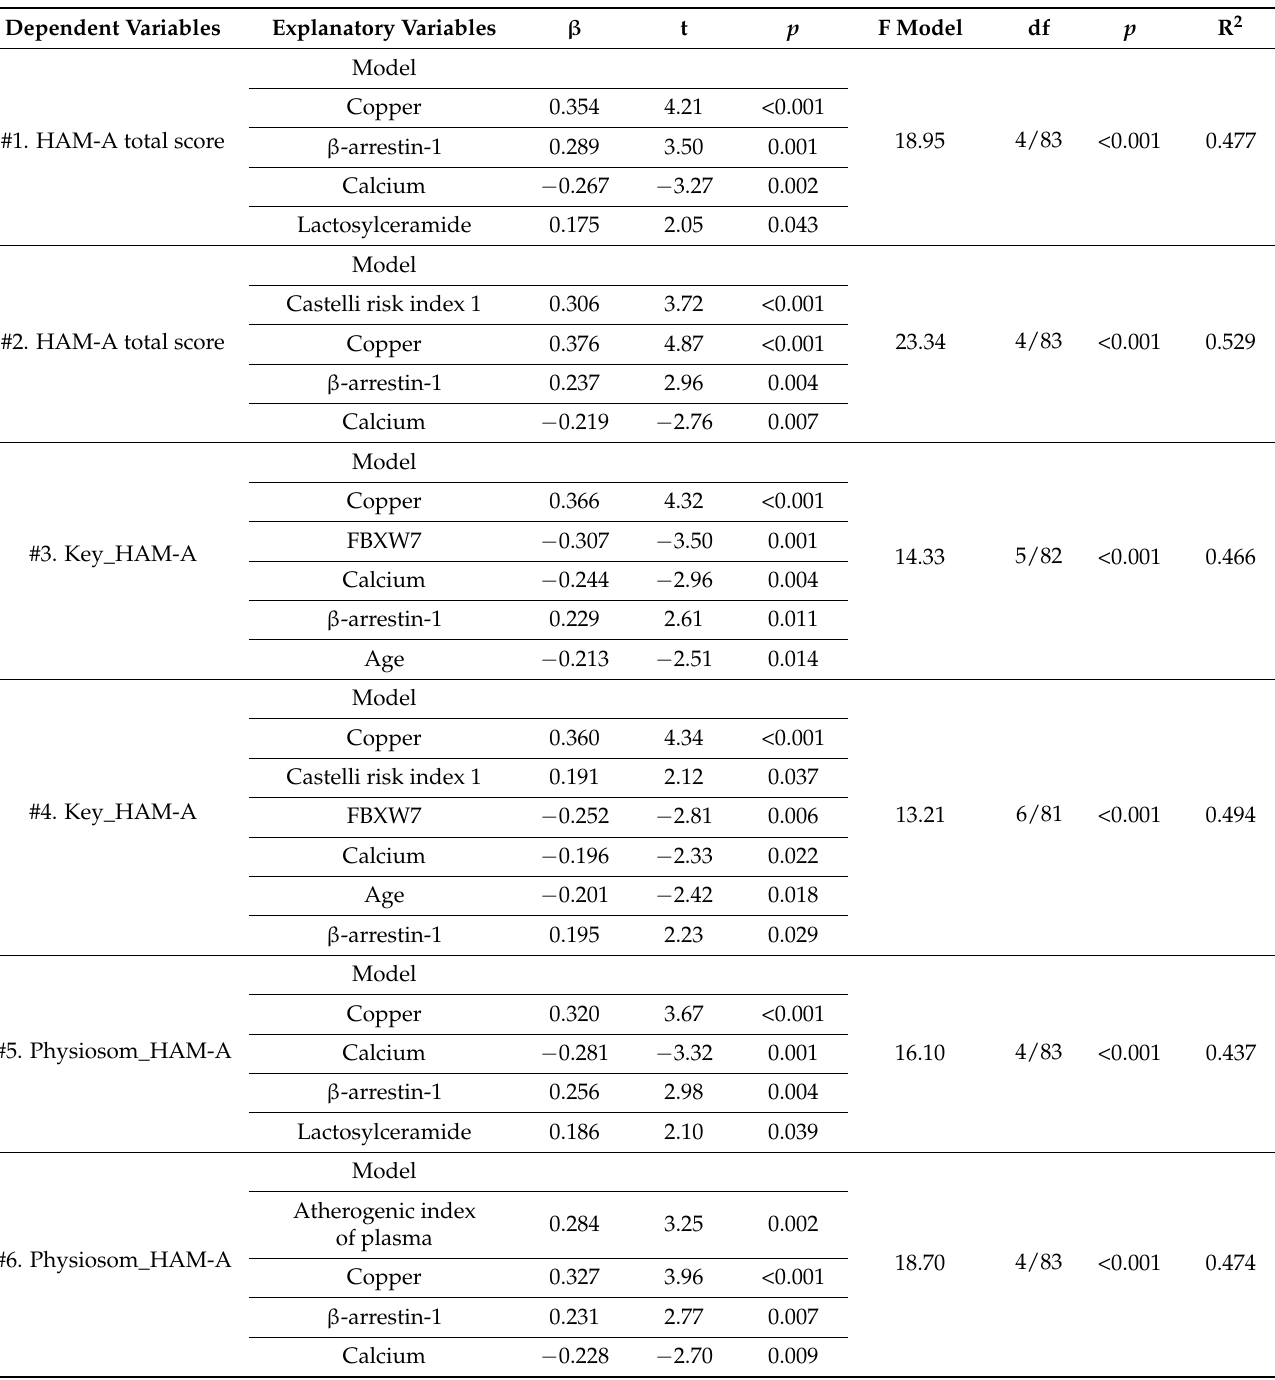
Table 4. Results of multiple regression analysis with the Hamilton Anxiety Rating Scale (HAM-A) scores as dependent variables and biomarkers as explanatory